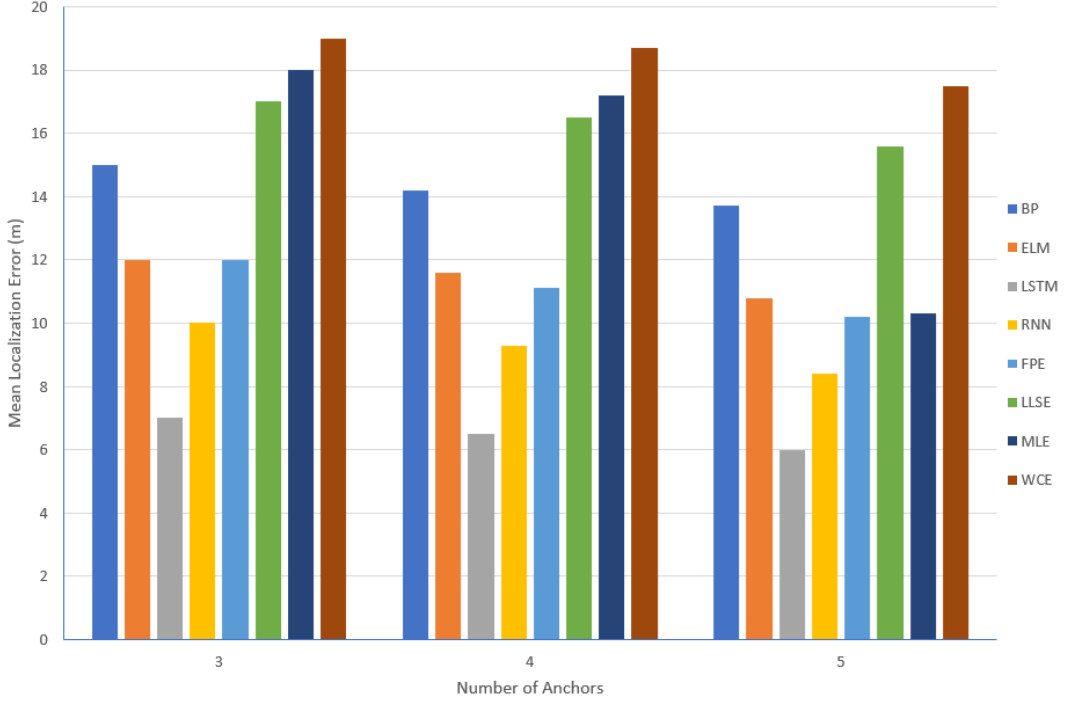
Figure 17. Mean localization errors with different number of anchors for all the